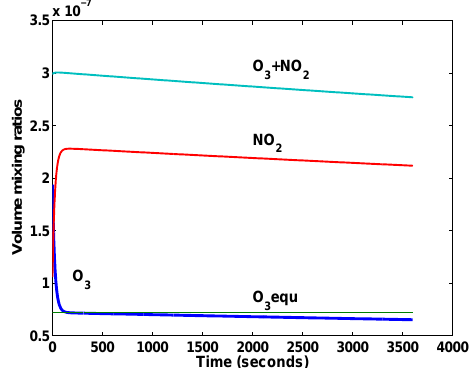
Fig. 18. Evolution of the mixing ratios of NO x and O 3 after injec- tion of 1ppmv of NO x at 200hPa (initial conditions for the sim- ulation: 0.2ppmv for O 3 and T = 230K). The O 3 concentration decreases rapidly due to titration by NO 2 . The odd oxygen species (O 3 + NO 2 ) show a slower continuous decrease. Reprinted from Cariolle et al. (2009). An edited version of this paper was published by AGU. Copyright (2009) American Geophysical